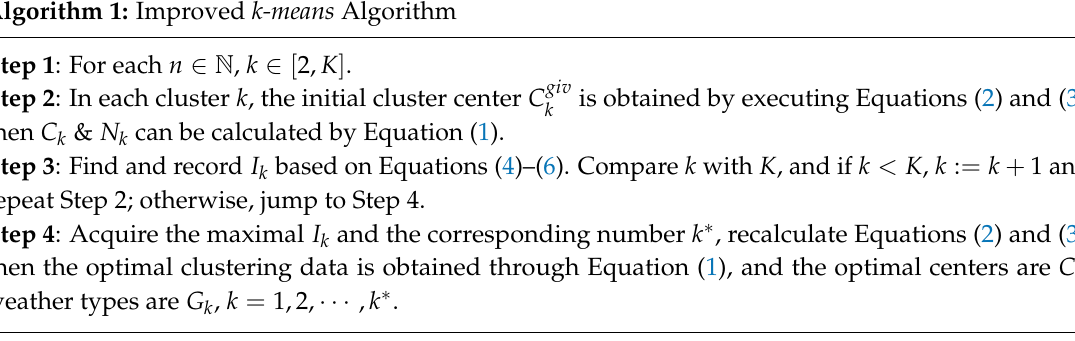
Algorithm 1: Improved k-means